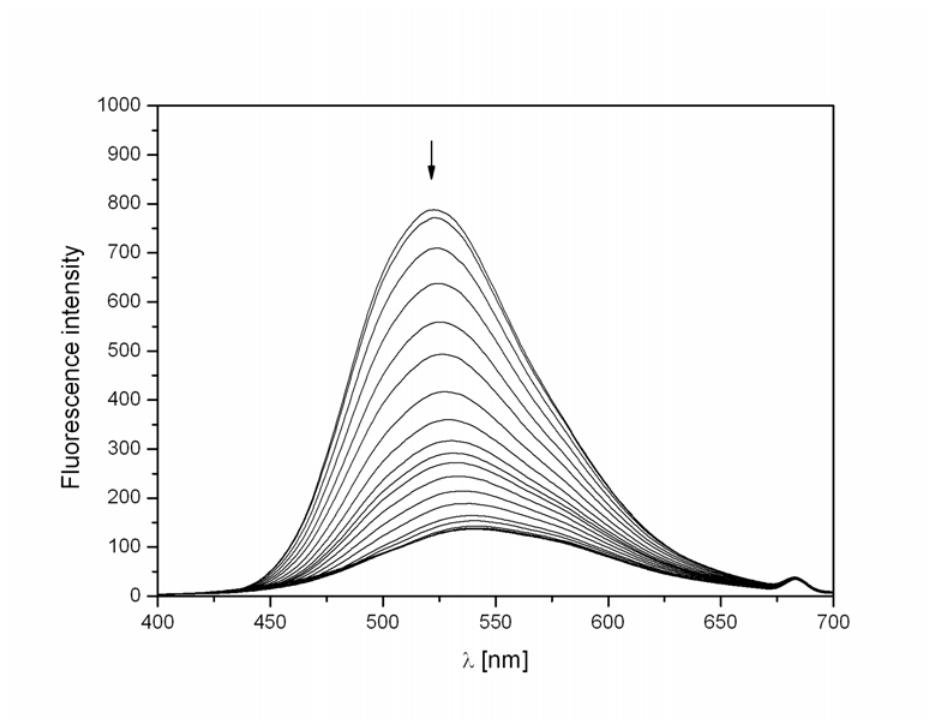
Fig. 4a Spectrofluorimetric titration of A18C6-Dns in acetonitrile solution (2.1 · 10 − 5 mol dm − 3 ) with calcium perchlorate (0-4.1 · 10 − 4 mol dm − 3